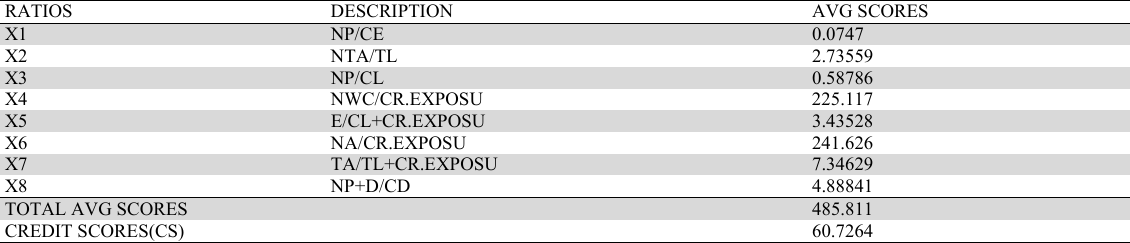
Risk description model – Ratio Measurement(Siyaram)